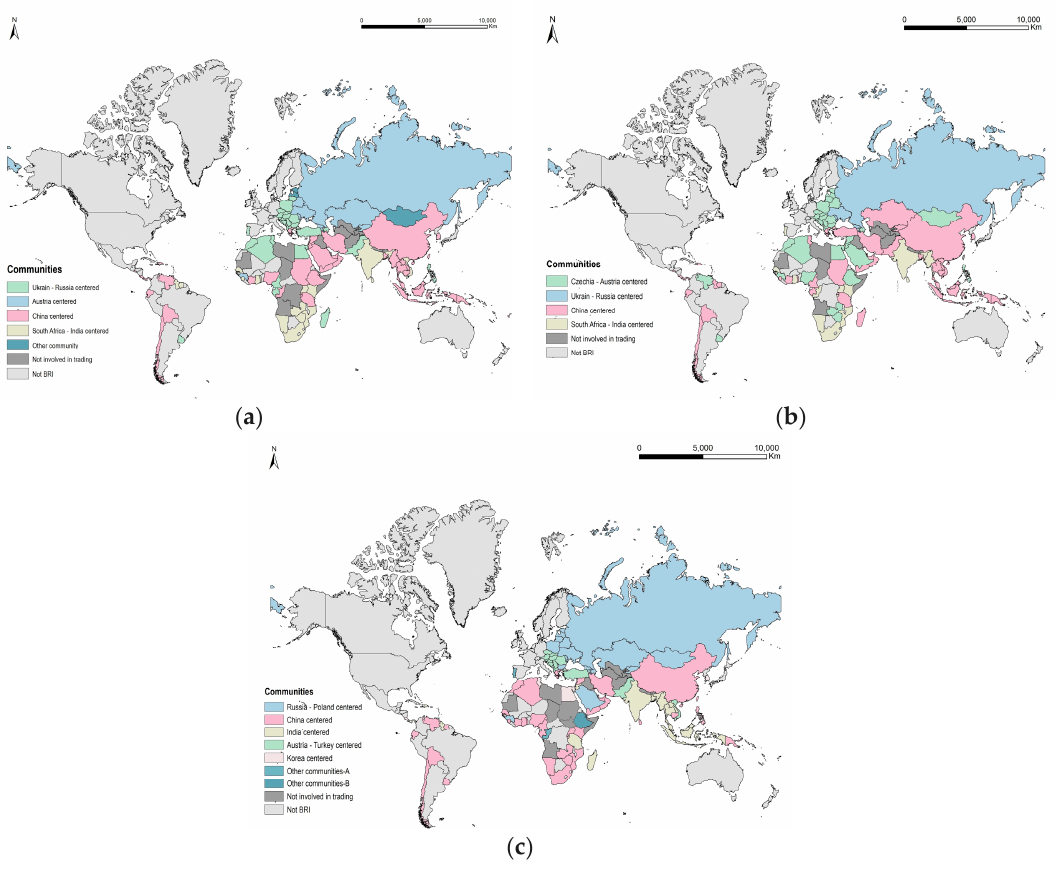
Figure 6. Community structure of trade of rolling stock products in the BRI region: ( a ) phase 1 (2003–